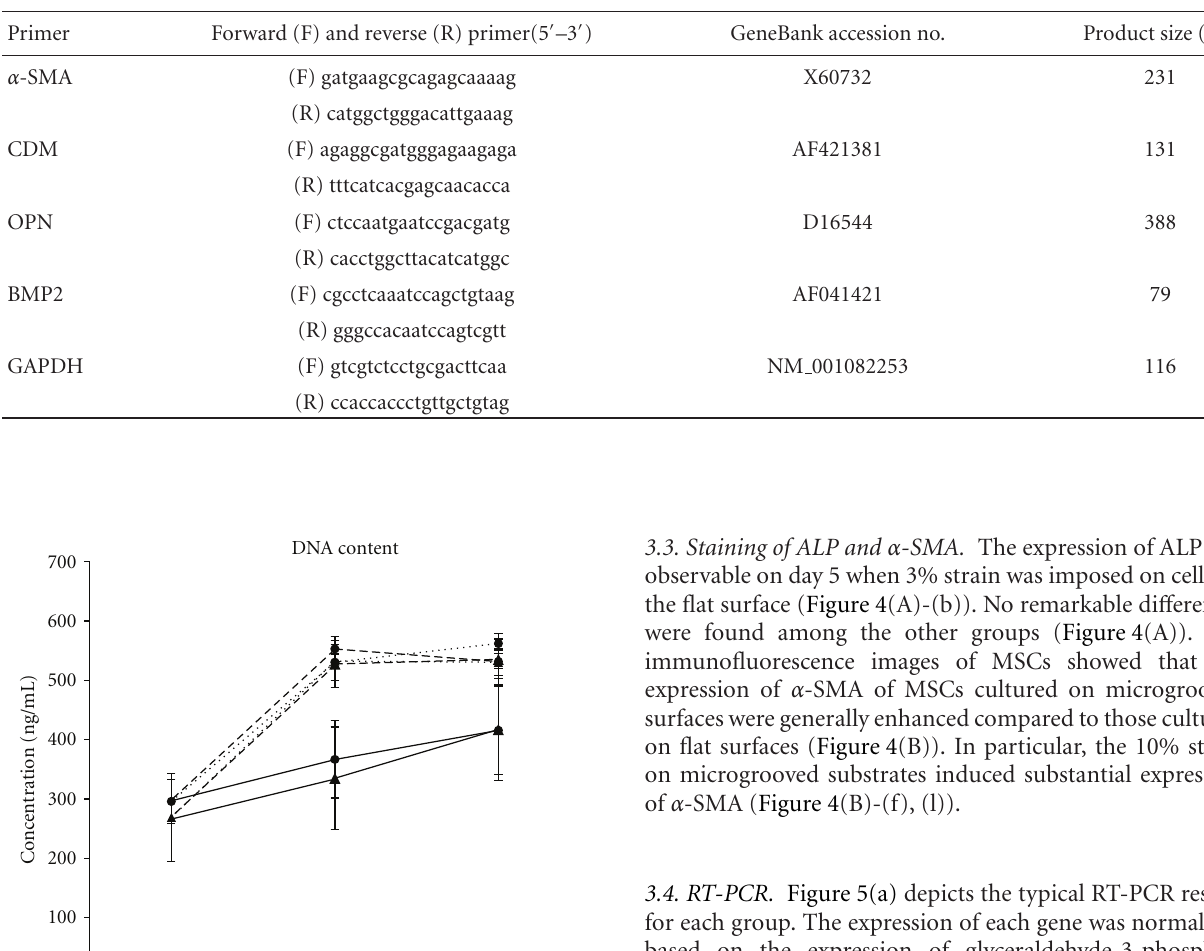
Table 1: Sequence of PCR primers and product sizes. α -SMA: α -smooth muscle actin, CDM:caldesmon, OPN:osteopontin, BMP2:bone morphogenic protein-2.